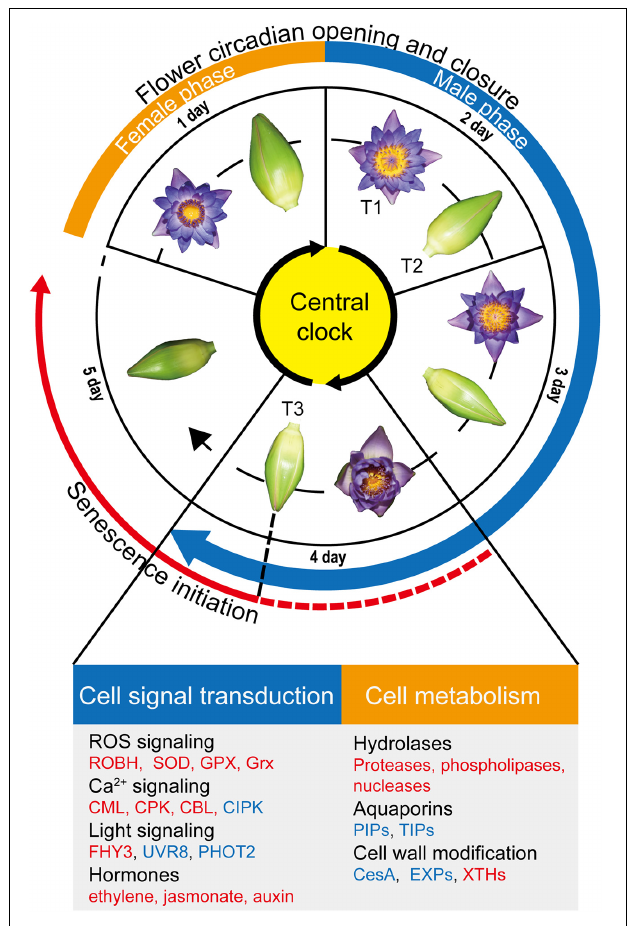
FIGURE 6 | Overview of flower circadian opening and closure and flower senescence regulation. The flowers of Nymphaea ‘Blue Bird’ (waterlily) exhibit daily opening and closure movements for four days, followed by no further reopening as well as wilting from the fifth day. waterlily flowers are protogynous; the first blooming day is the female phase, and the male phase begins from the second blooming day and continues to the fourth day. We found that the senescence process was initiated from the last closure stage (T3) in the petals (red solid line), and speculate that the process possibly begins from as early as the start of the fourth day due to the smaller opening size of flowers on the fourth day (red dotted line). Genes involved in cell signal transduction and metabolism were listed below. The upregulated pathways/genes at T3 are marked in red, and the downregulated pathways/genes are marked in